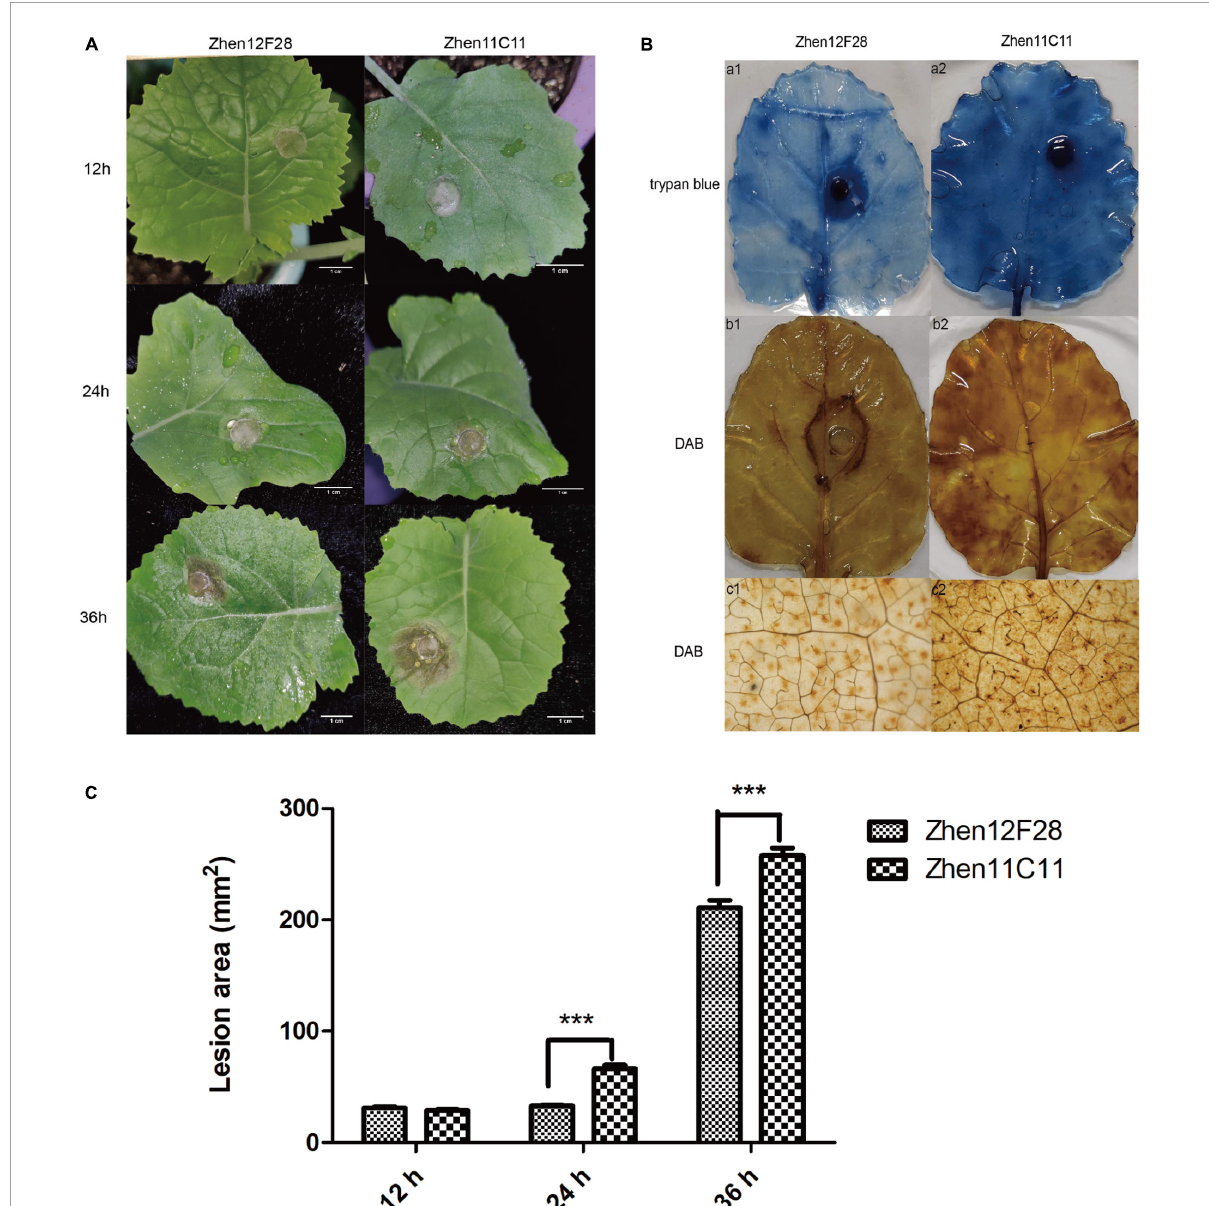
FIGURE5 Evaluation of disease development. (A) Disease symptoms of leaves in Zhen12F28 (R-line) and Zhen11C11 (S-line) 12, 24, and 36 h post inoculation with S. sclerotiorum . Scale bar = 1 cm. (B) Trypan blue and DAB staining in the leaves of Zhen12F28 (R-line) and Zhen11C11 (S-line) at 36 h after inoculation. a1 and a2: Trypan blue staining; b1 and b2: DAB staining; c1 and c2: DAB staining imaged under microscope. (C) Lesion area of inoculated leaves in Zhen12F28 and Zhen11C11 at 12, 24, and 36 h post inoculation. Error bars are mean ± SEM, n = 3. Significant differences between the two lines at each time point are denoted as follows: *** P <